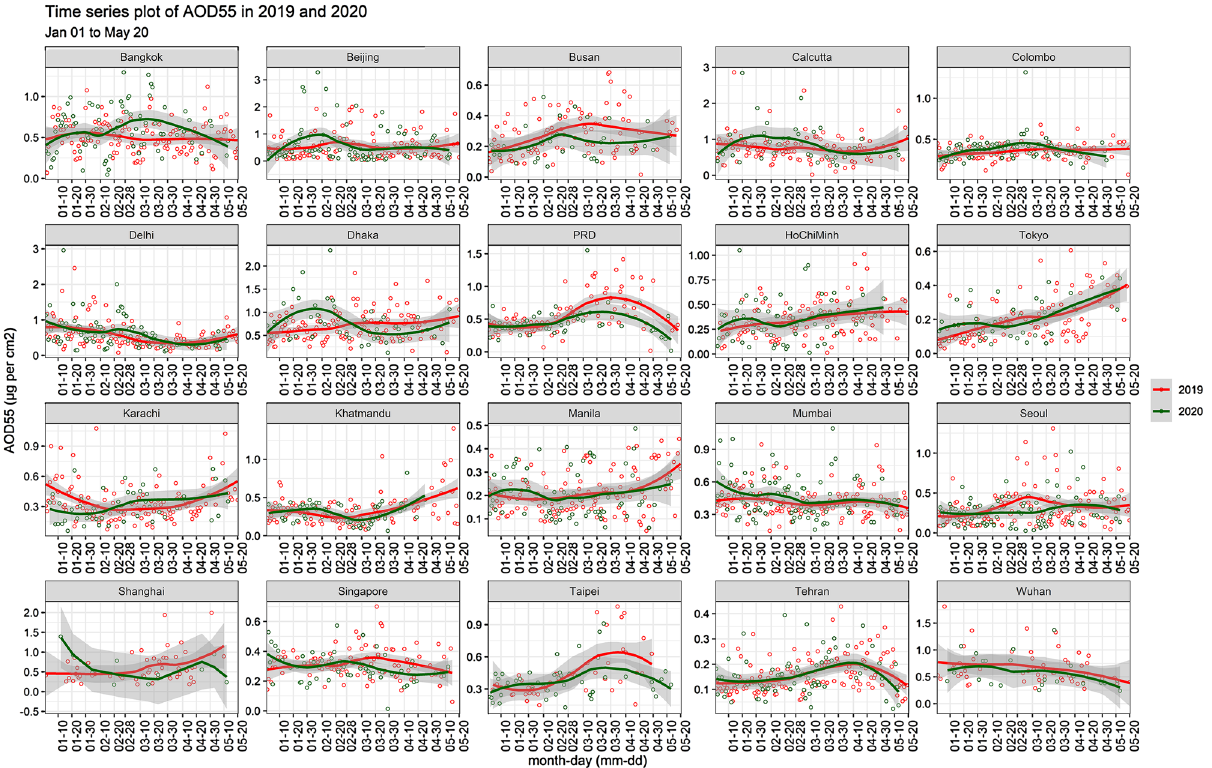
Figure 1. Comparison of daily changes in AOD concentration of the cities in 2019 and